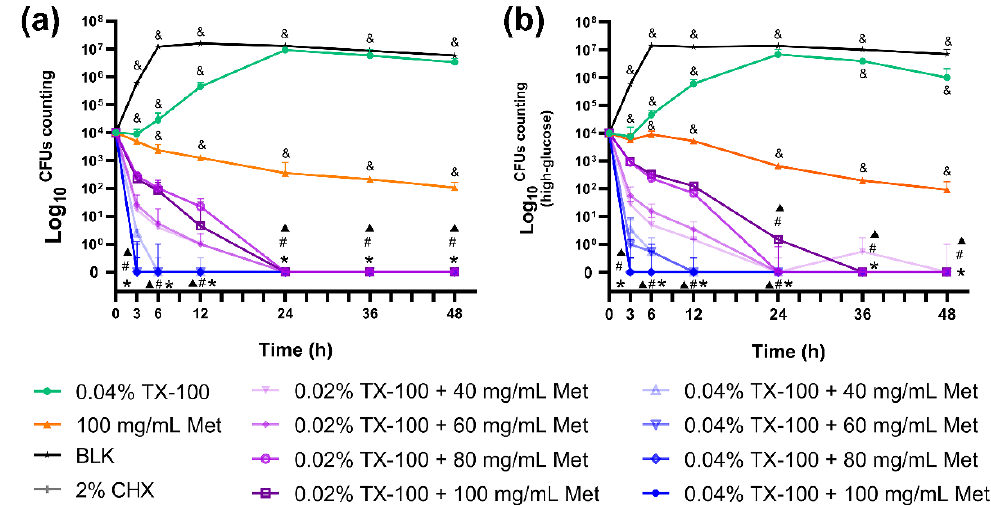
Figure 1. Dynamic time-killing curves. ( a ) in normal BHI; ( b ) in high-glucose BHI. (*: significant difference compared with the blank control group; ▲ : significant difference compared with the 0.04% TX-100 group; #: significant difference compared with the 100 mg/mL Met group; &: significant difference compared with the 2% CHX group; p < 0.05). Table 3. The antibiofilm activities of TX-100 and Met with or without TX-100 against E. faecalis in normal and high-glucose